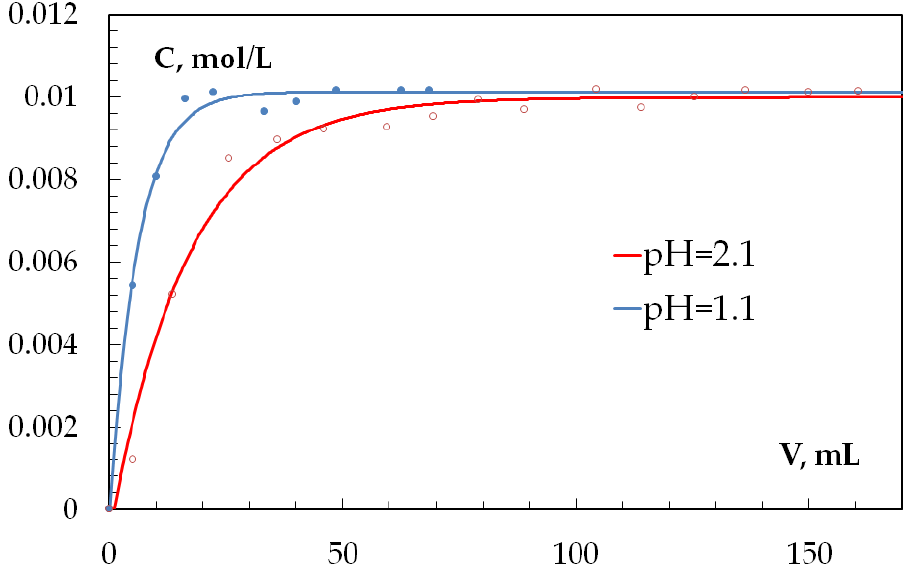
Figure 6. Elution curves of Mn 2+ solution at different initial pH values.